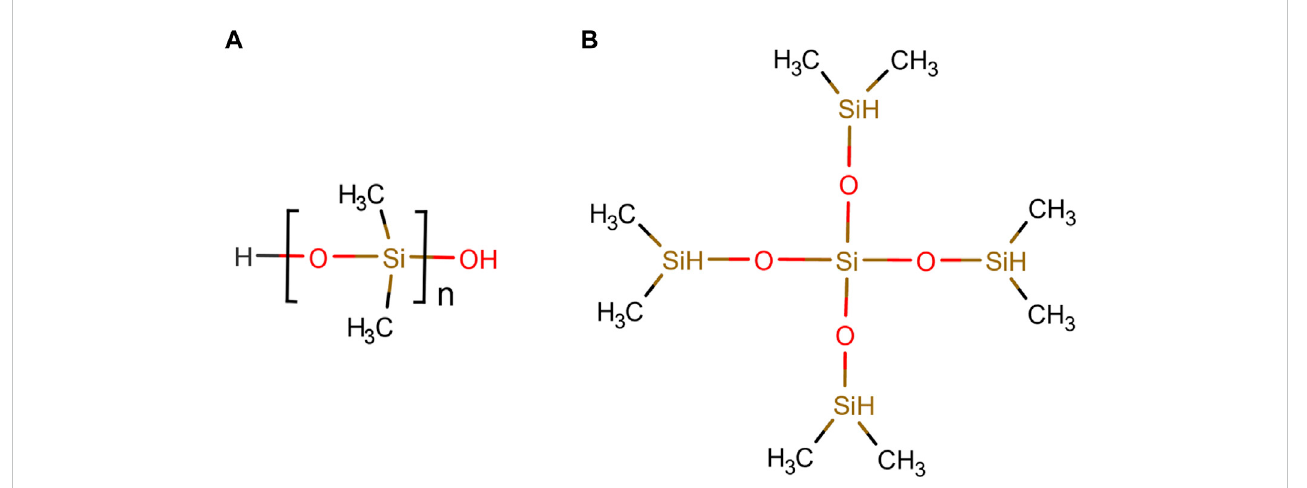
FIGURE 1 Structural formula of (A) polydimethylsiloxane (PDMS) and (B) linker molecule.